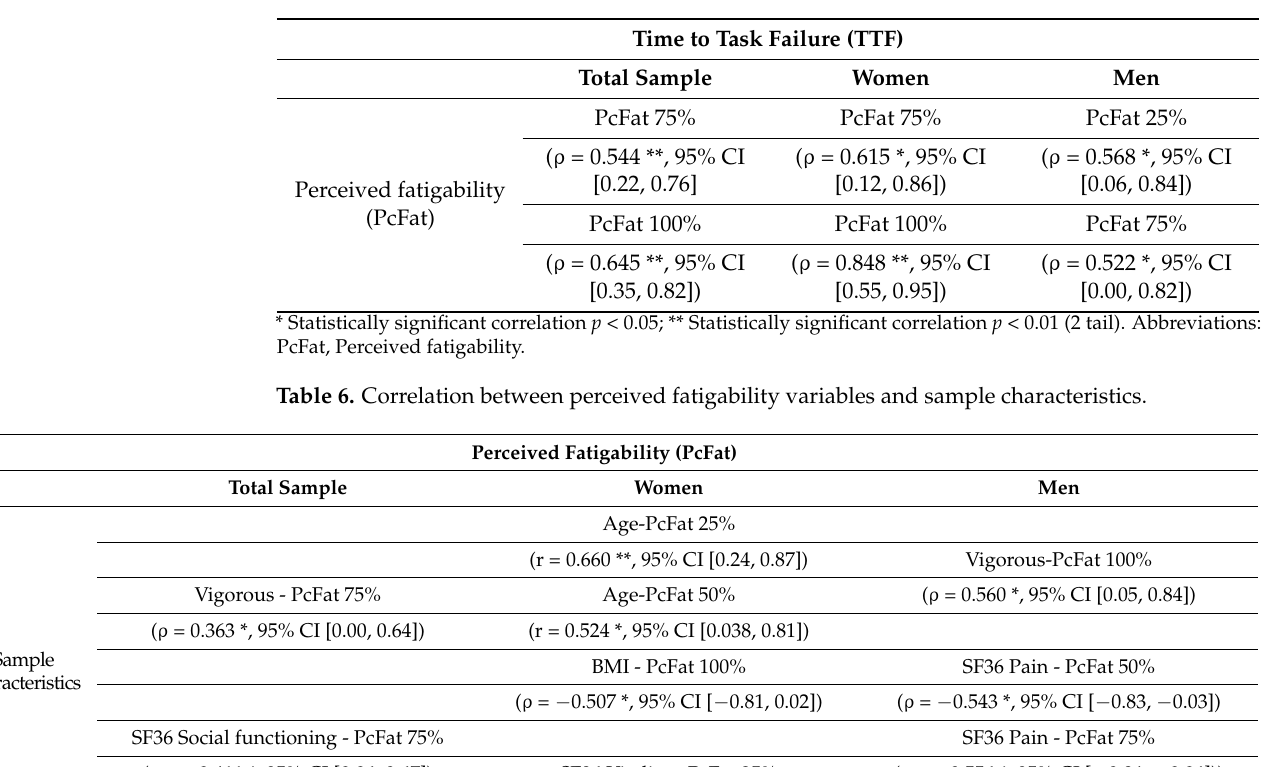
Table 5. Relations between perceived and performance fatigability.